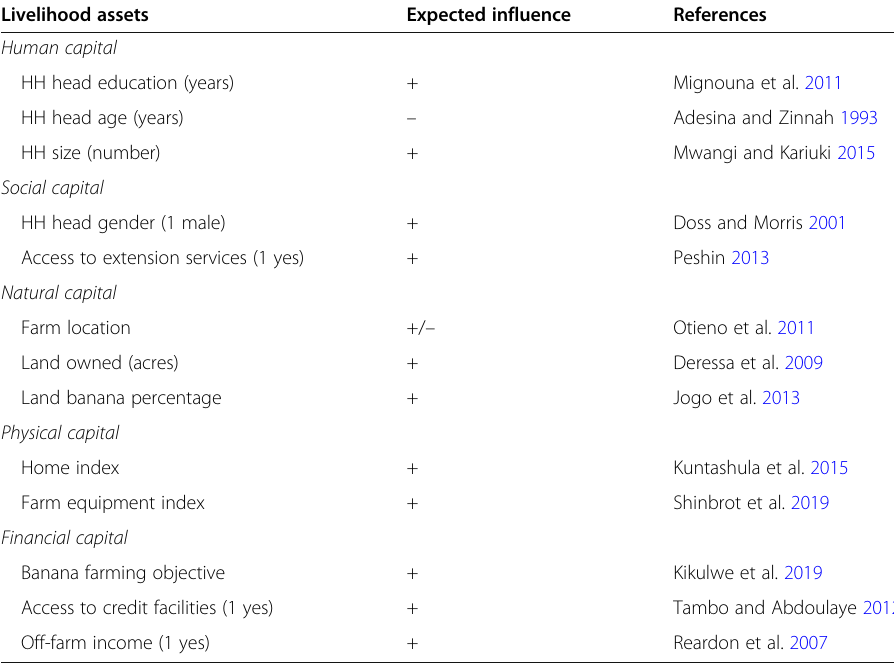
Table 1 Livelihood assets selected and their expected influence on adoption of the BXW control strategy Livelihood